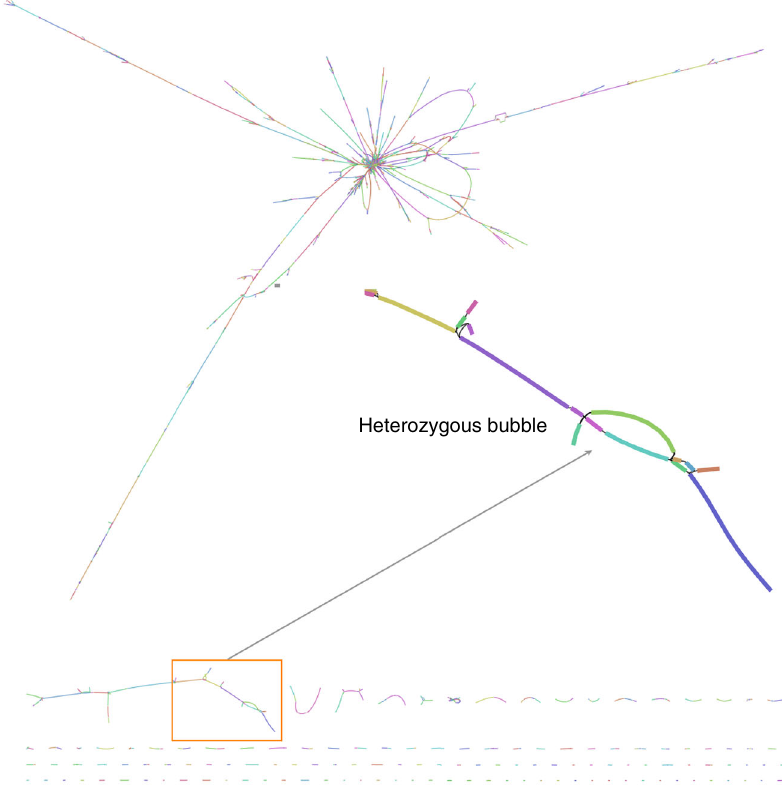
Fig. 1 Genome assembly graph of S. lepidophylla . Each line (node) represents a contig with connections (edges) representing ambiguities in the graph structure. A subset of the graph showing heterozygous bubbles is enlarged. Contig color is randomly